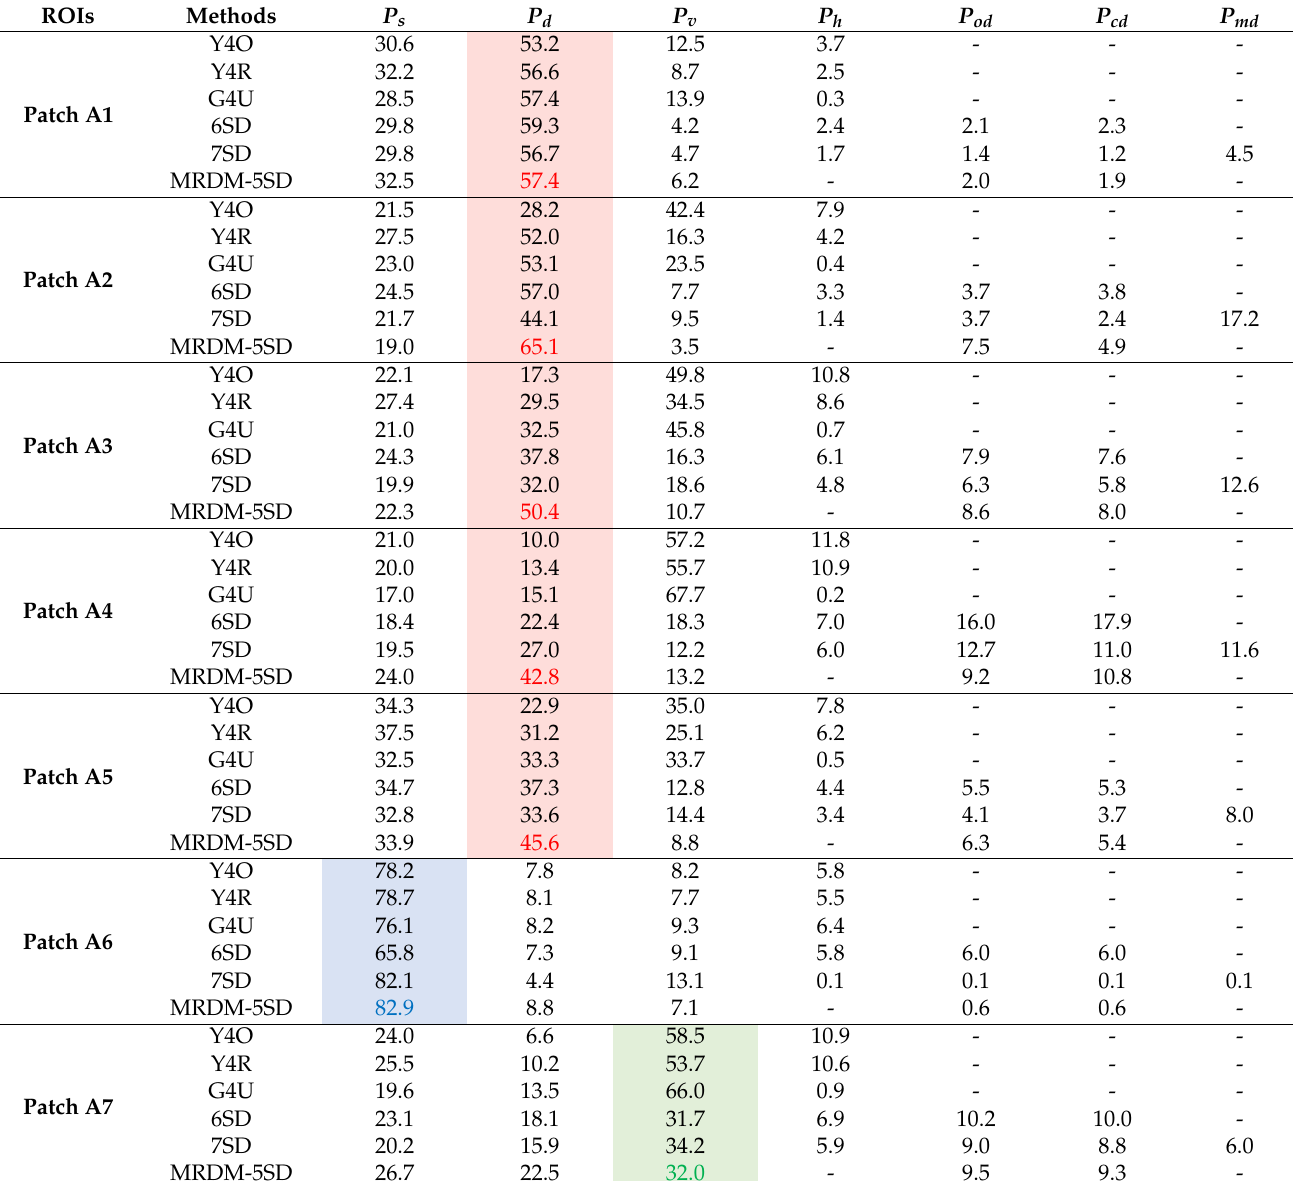
Table 2. Scattering contributions (%) of Patch A1-A7 for ALOS-2/PALSAR-2 data sets. ROIs Methods